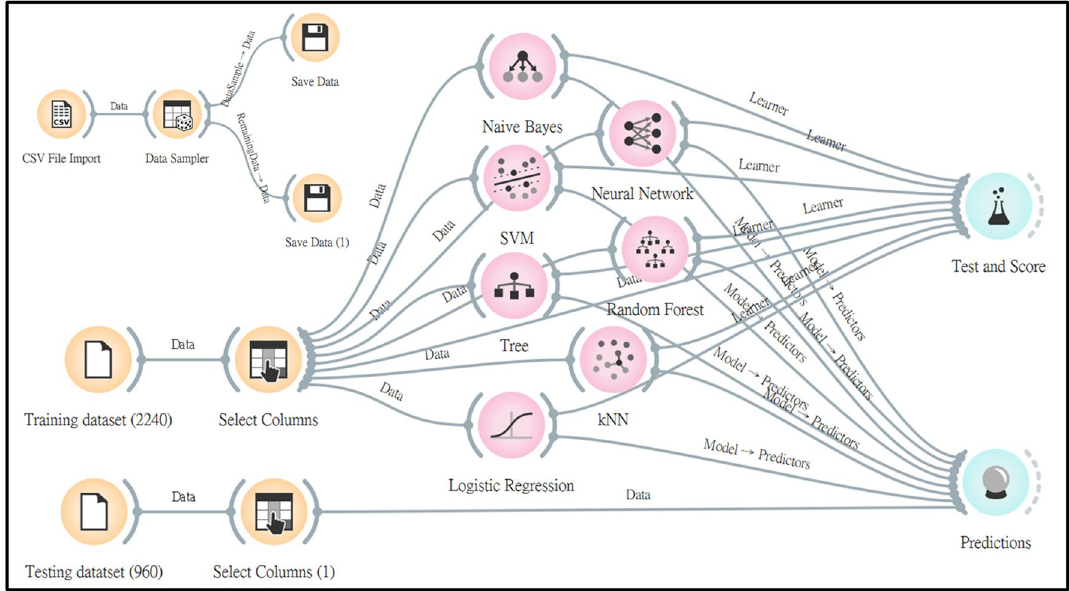
Figure 2. Workflow for Orange software, Version 3.27.1. SVM Support vector machine; Tree Classification tree; kNN k-nearest